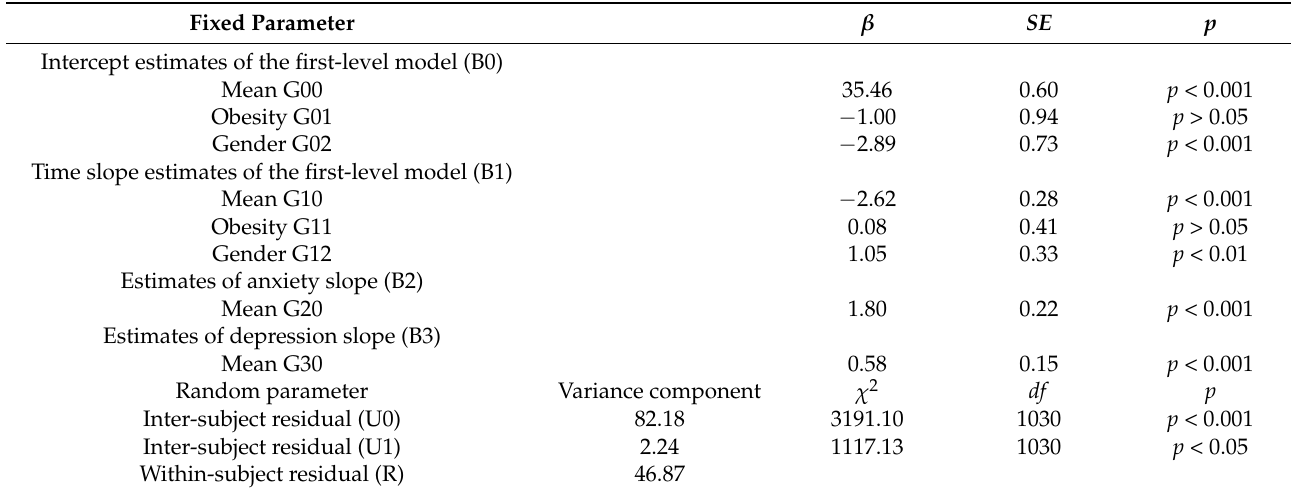
Table 4. Analysis results of the complete